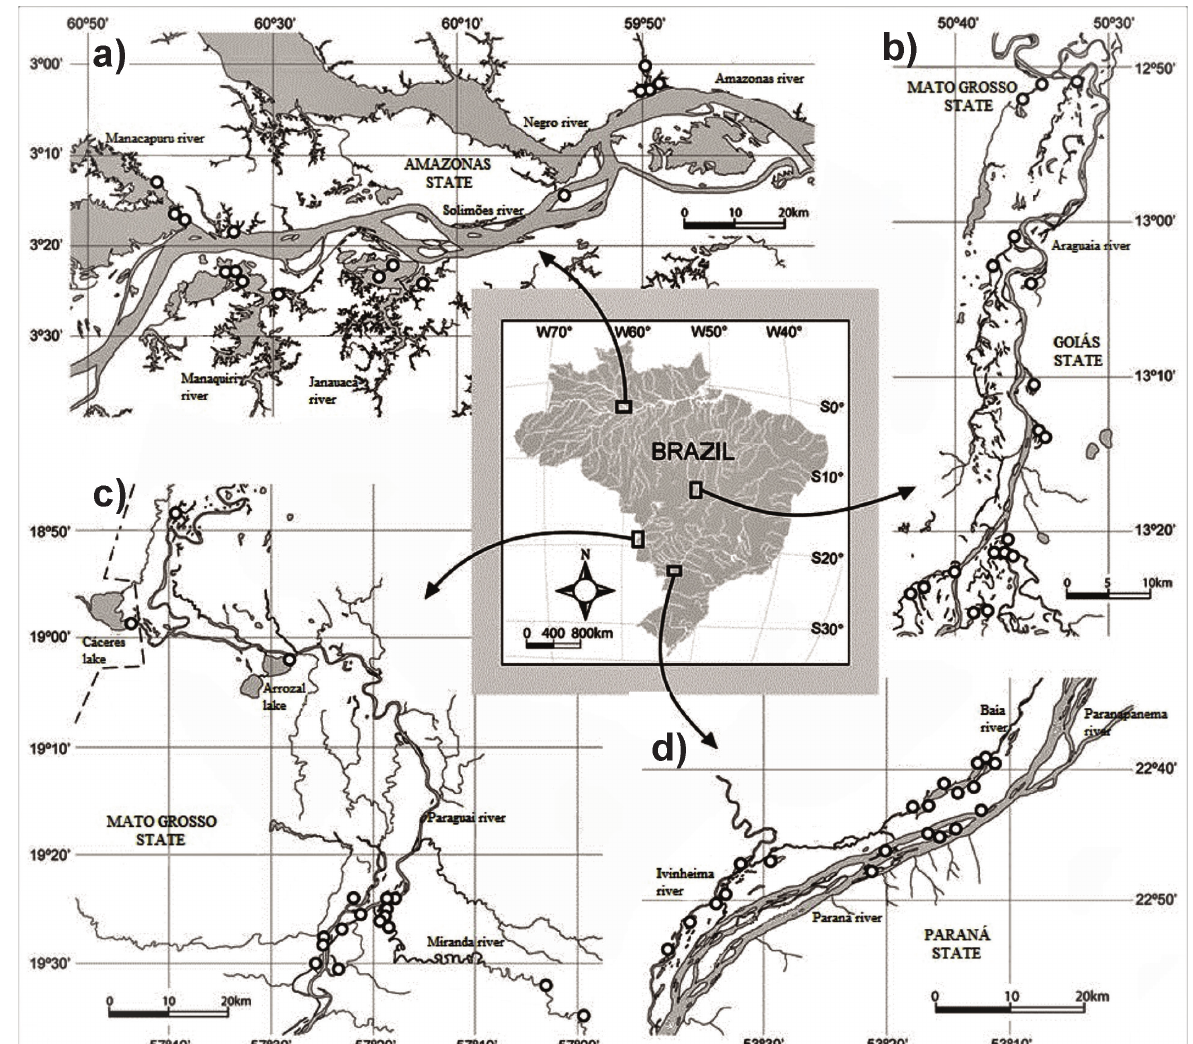
Figure 1. Study area with the location of the sites sampled in each floodplain: a) Amazon River; b) Araguaia River; c) Pantanal and d) Upper Paraná River,